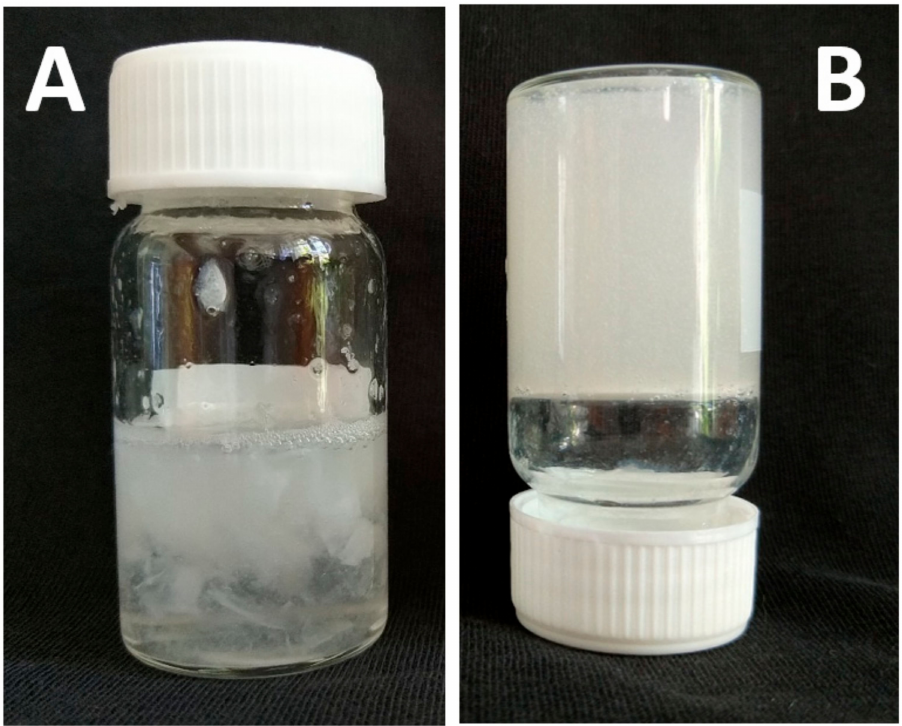
Figure 4. Formation of hydrogel from the same source of collagen however isolated by different way. ( A ) phosphate buffer pre-treatment and extraction by 0.1 M acetic acid; collagen gelled only locally ( B ) ethanol pre-treatment and extraction by 0.02 M acetic acid followed by neutralization by 0.1 M NaOH to pH = 7, collagen precipitate is centrifugated and dissolved again in 0.02 M acetic acid; collagen gelled